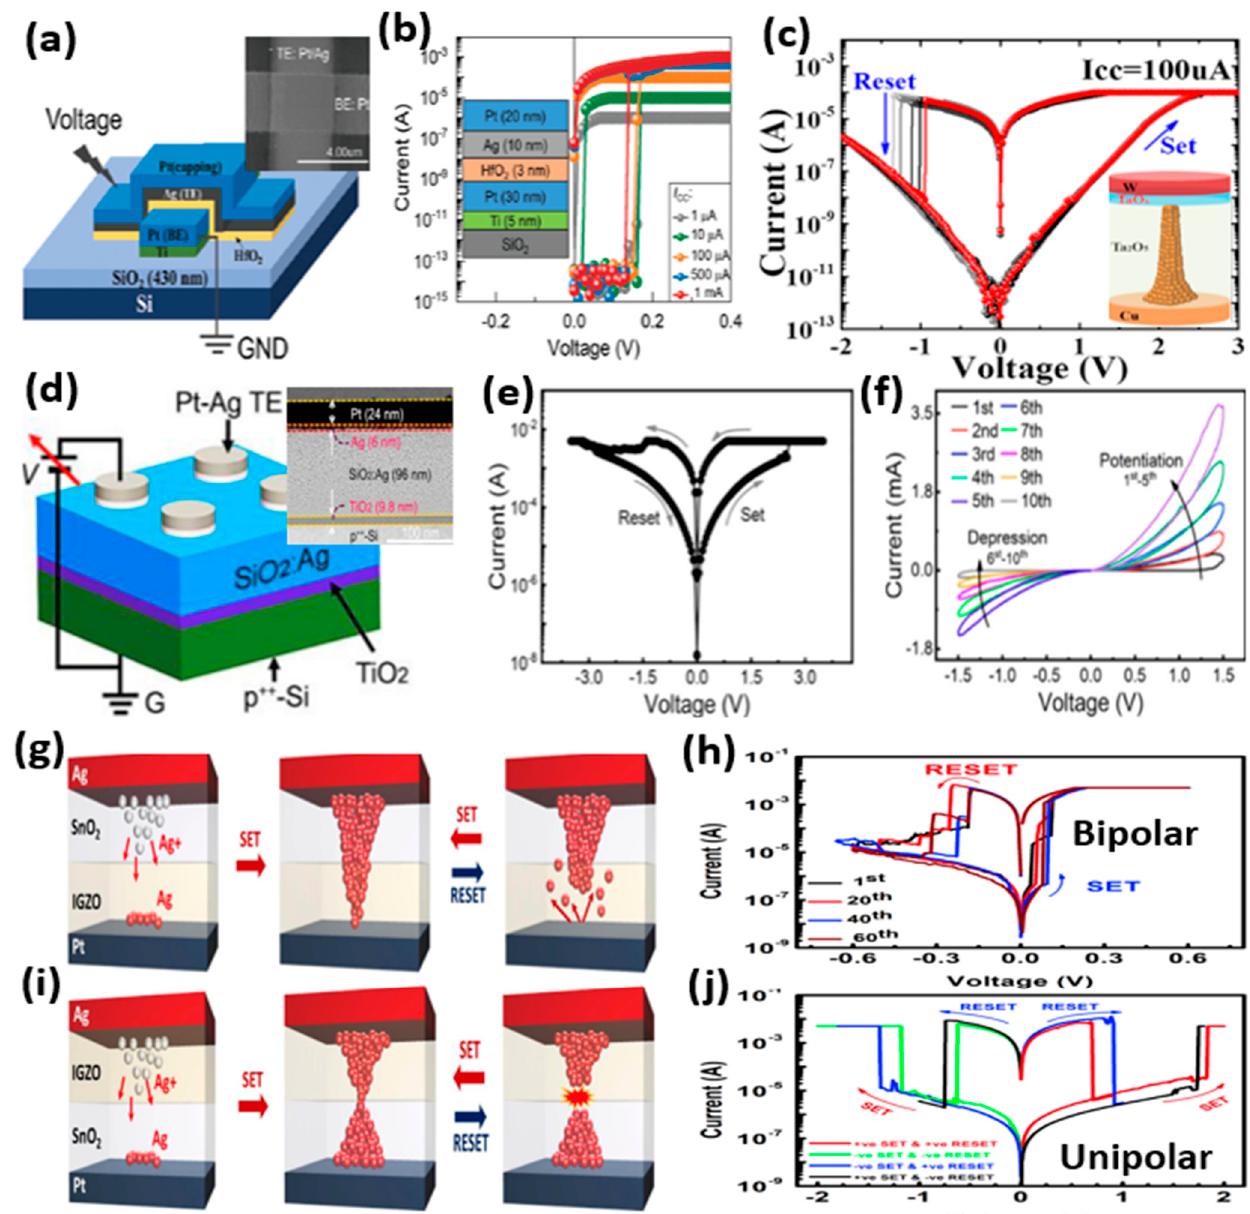
Figure 4. The CBRAM devices with metal oxide-based switching materials. ( a ) The schematic diagram of the crossbar structure of the Ag/HfO 2 /Pt CBRAM device with a top-view SEM image of the cross-point. ( b ) The I–V characteristics of the Ag/HfO 2 /Pt device under different compliance currents present TS characteristics. Reprinted from Ref. [33]. ( c ) The typical I–V characteristics of the CBRAM device with a bilayer Ta 2 O 5 /TaO x switching medium. The inset shows a schematic of the device structure. Reprinted from Ref. [43]. ( d ) The schematic diagram of a CBRAM device based on SiO 2 :Ag and TiO 2 bilayer switching medium with a cross-sectional TEM image of the device. The I–V characteristics of the SiO 2 :Ag and TiO 2 bilayer-based device present ( e ) digital bipolar switching and ( f ) and bidirectional analog switching. Reprinted from Ref. [44]. ( g ) The schematic diagram of the device with a switching layer stacking of SnO 2 /IGZO and ( h ) its corresponding I–V characteristics with bipolar switching. ( i ) The schematic diagram of the device with a switching layer stacking of IGZO/SnO 2 and ( j ) its corresponding I–V characteristics with unipolar switching. Reprinted from Ref. [45].